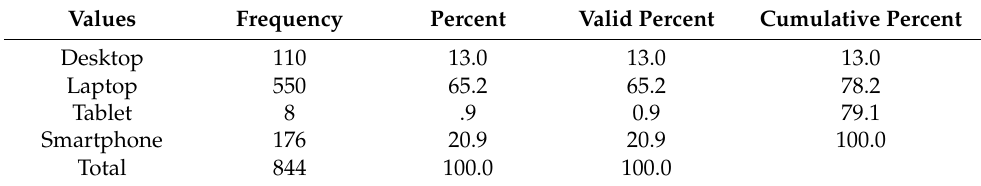
Table 6. Type of electronic devices used by students in online classes.